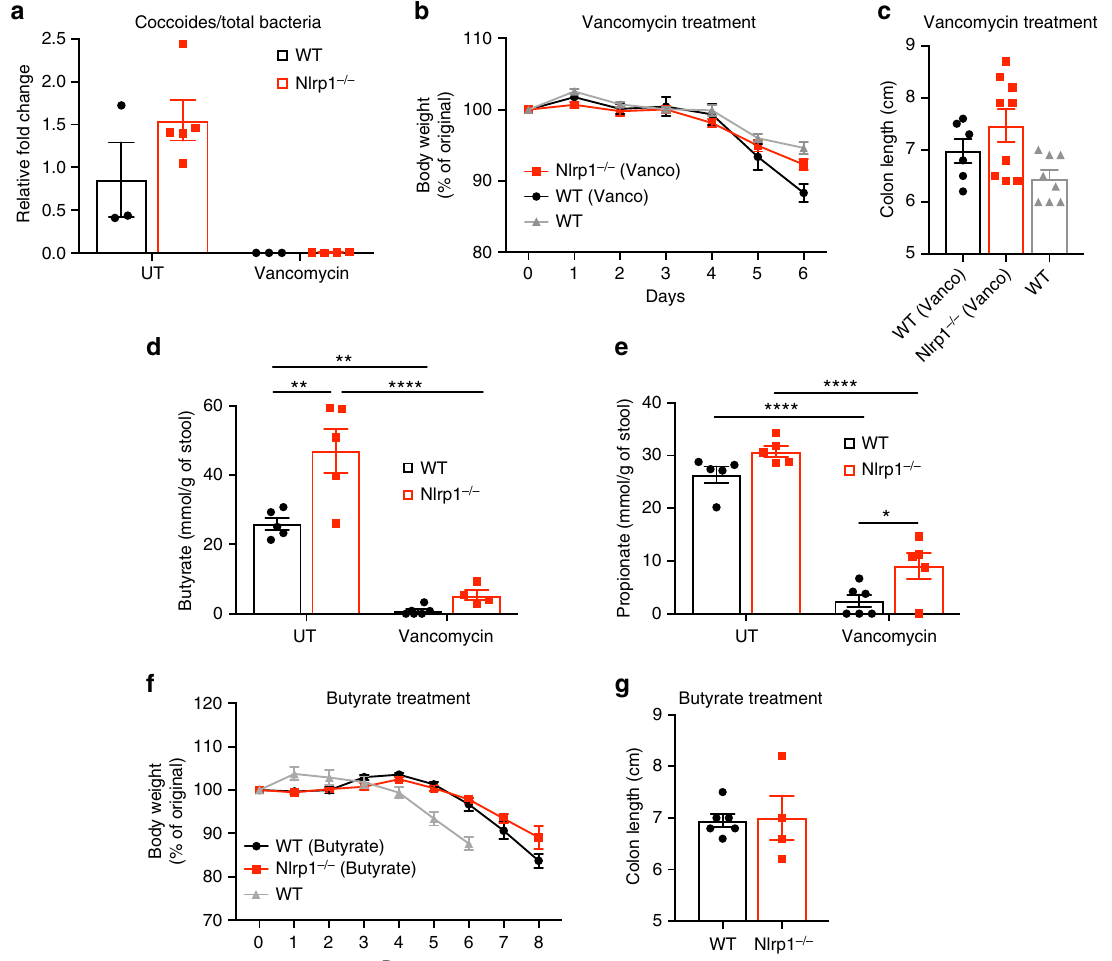
Fig. 3 Vancomycin treatment or supplementation with butyrate ablates the Nlrp1 phenotype. a Stool from WT and Nlrp1 − / − mice was harvested before and after vancomycin (50 mg/L) treatment for 4 weeks. Bacterial DNA from stool was isolated from untreated (UT) and vancomycin-treated mice, and depletion of the Coccoides group (belonging to the Clostridiales phylum) was con fi rmed using speci fi c 16S primers by quantitative PCR. Results were normalized to the total bacteria present in the stool. b Vancomycin-treated mice were subjected to 3% (w/v) DSS for 6 days and disease severity was measured according to percentage weight loss and c colon length. Short chain fatty acid analysis was performed on fecal samples collected from WT and Nlrp1 − / − mice before (UT) and after vancomycin treatment. The concentration of d butyrate and e propionate was measured by gas chromatography mass spectrometry. f WT and Nlrp1 − / − mice were supplemented with 2% butyrate in drinking water ad libitum for 28 days, and then subjected to 2.5% (w/v) DSS for 6 days and disease severity measured according to percentage weight loss or g colon length. Data are representative of 3 independent experiments with 3 – 6 mice per group. Means ± SEM; * p ≤ 0.05, ** p ≤ 0.01, **** p ≤ 0.0001. A two-tailed unpaired t- test was used to determine statistical signi fi cance between two groups; and a two-way ANOVA with Tukey ’ s post-hoc comparisons was performed on data that involved more than two